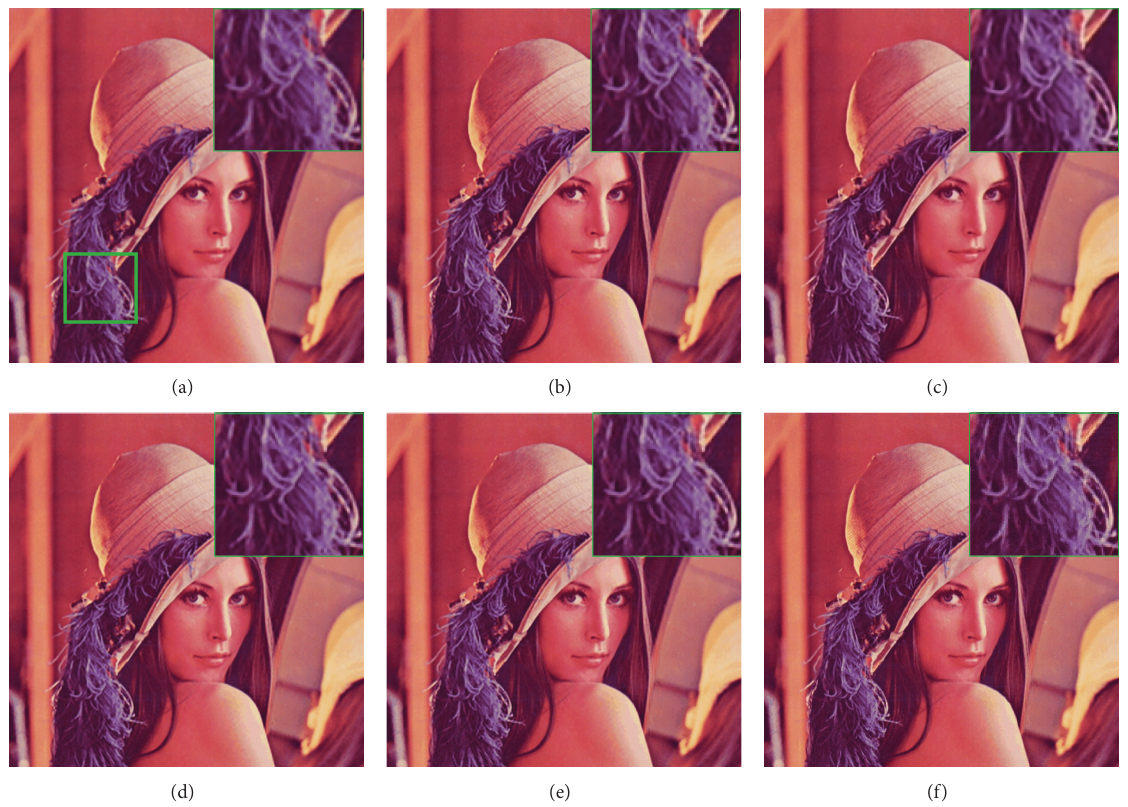
Figure 6: The comparison of the proposed algorithm and four other methods on 𝑙𝑒𝑛𝑎 image (2x), and the local magnification in green rectangle is shown in the upper right corner in each example. (a) Bicubic. (b) Zeyde et al. [12]. (c) Yang et al. [16]. (d) ANR [15]. (e) Our proposed. (f)